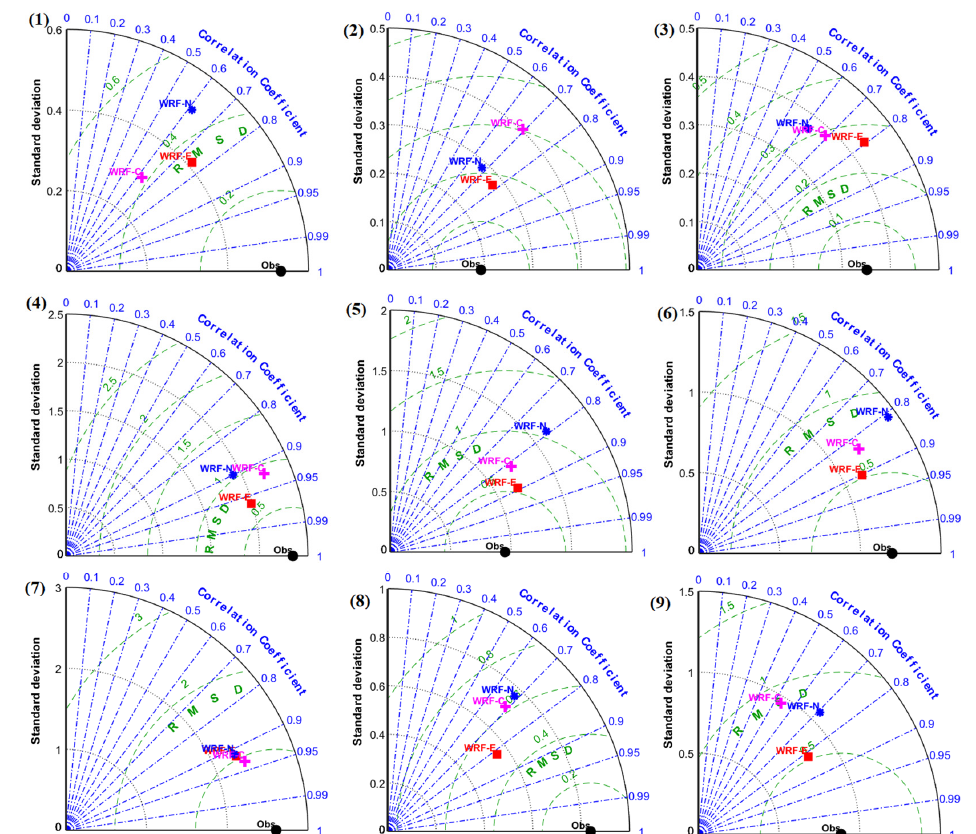
Figure A3. Daily average wind speed in m s − 1 from the models and observations at the locations ( a ) Dongsha, ( b ) Zhanjiang, and ( c ) Hong Kong.